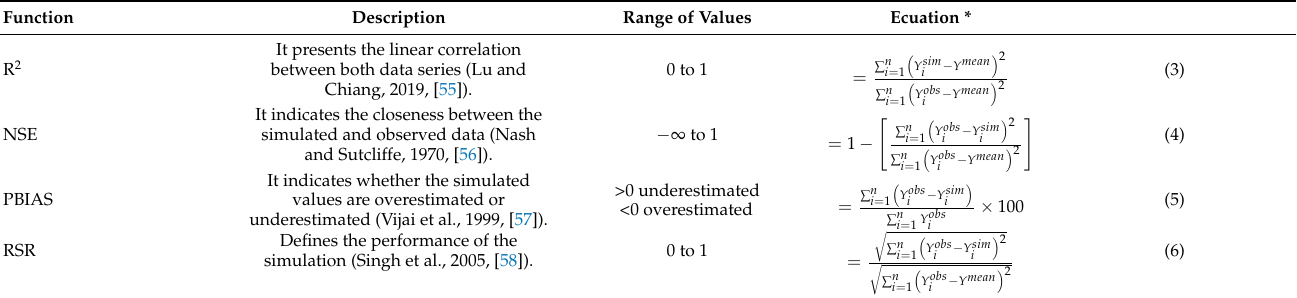
Table 2. Statistics to estimate the goodness of fit of the calibration and